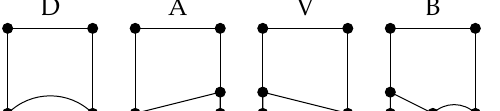
Figure 8. On the left side, Id = I ; on the right side, Id = ∅ .